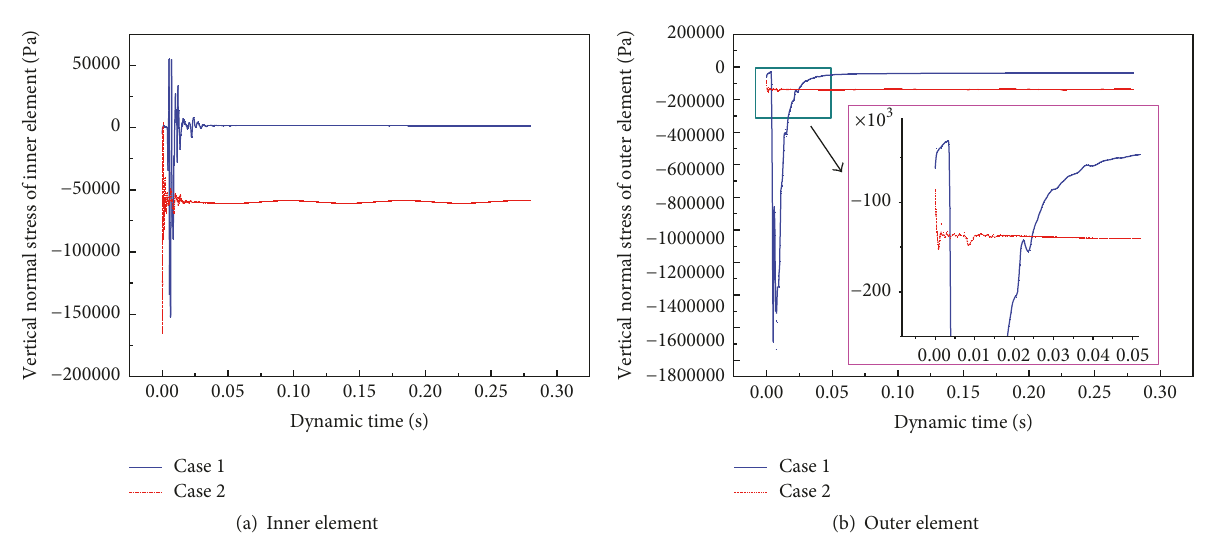
Figure 18: Vertical normal stress of inner and outer elements in the span center.